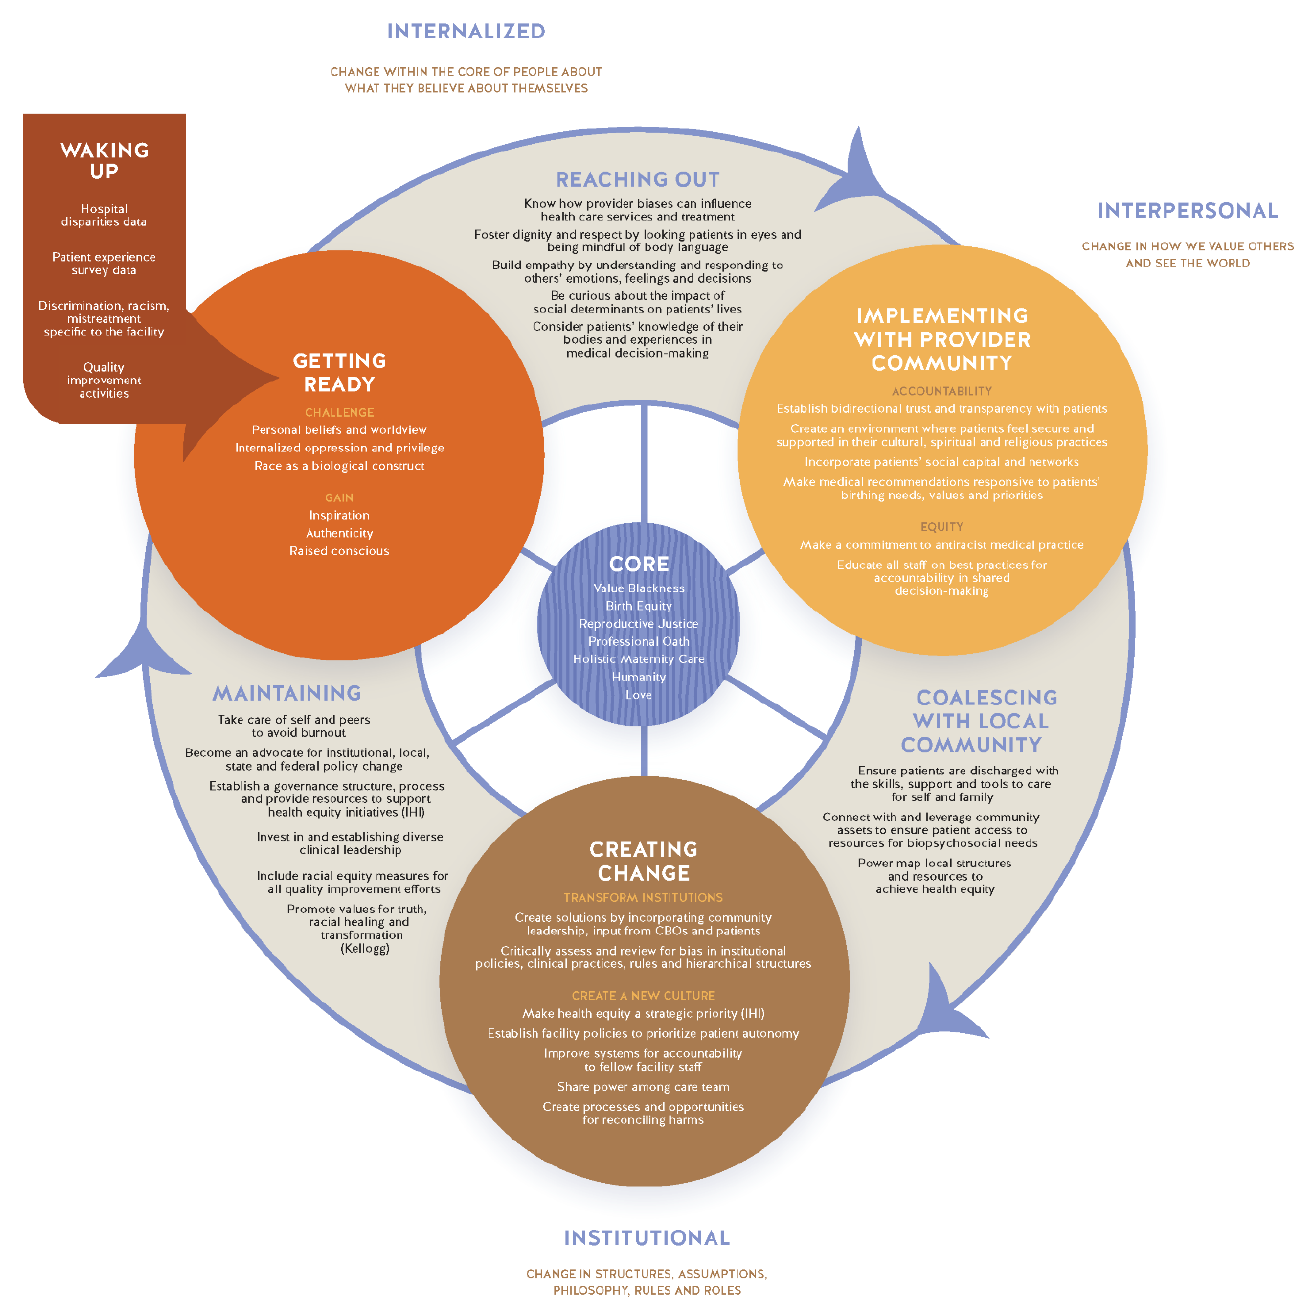
Figure 2. Cycle to Respectful Care.